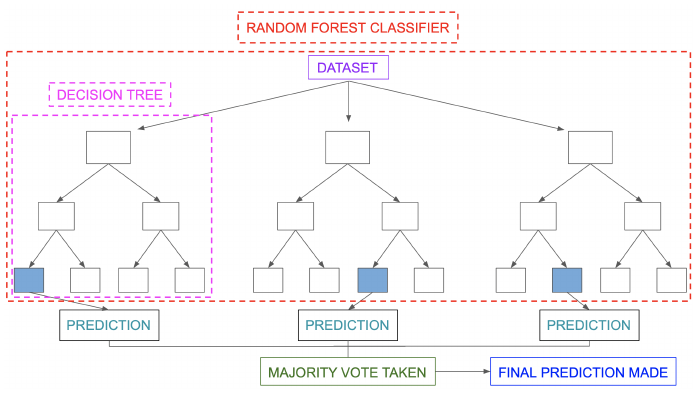
Figure 9. Random forest algorithm